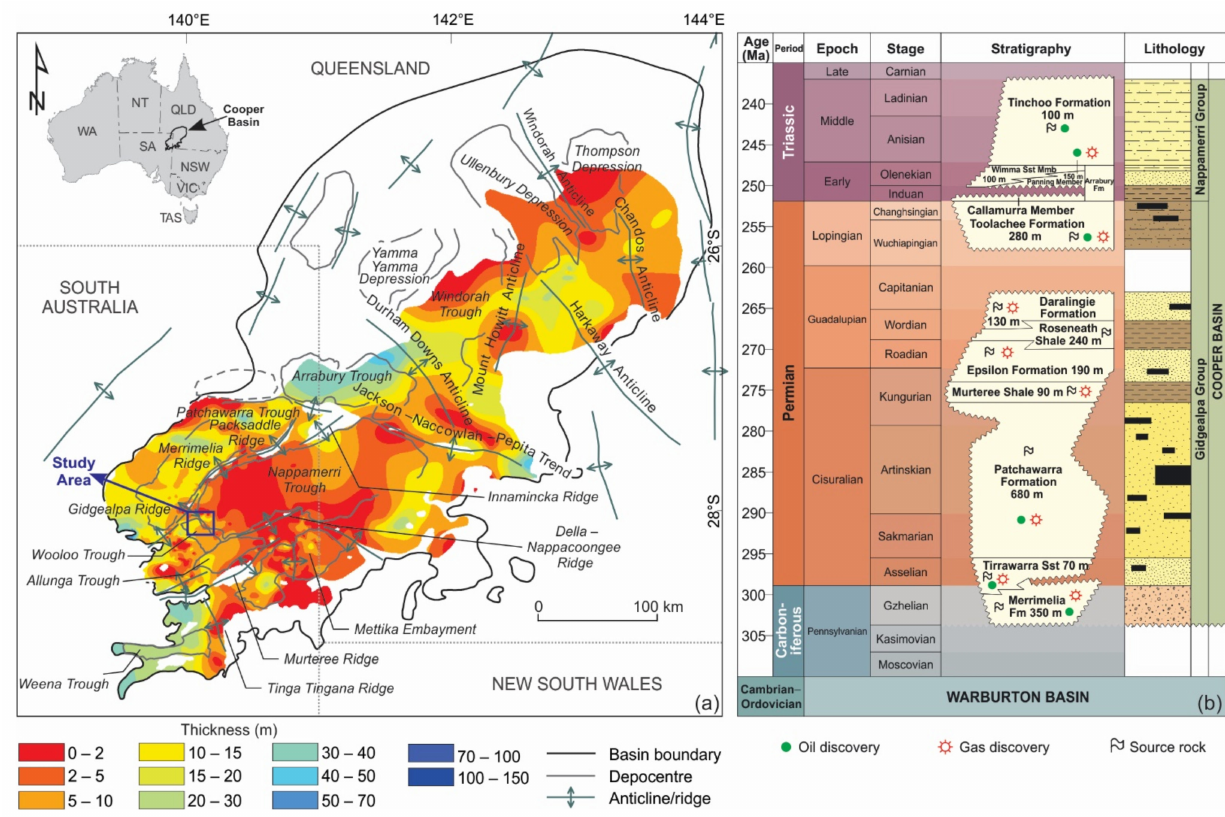
Figure 17. ( a ) Isolith map of the Patchawarra Coal showing net coal thickness in the Patchawarra Formation across the Cooper Basin, ( b ) the stratigraphic column of the Cooper Basin [186–188] (This figure was originally published in The AAPG Bulletin Vol 103 Issue 1 Pages